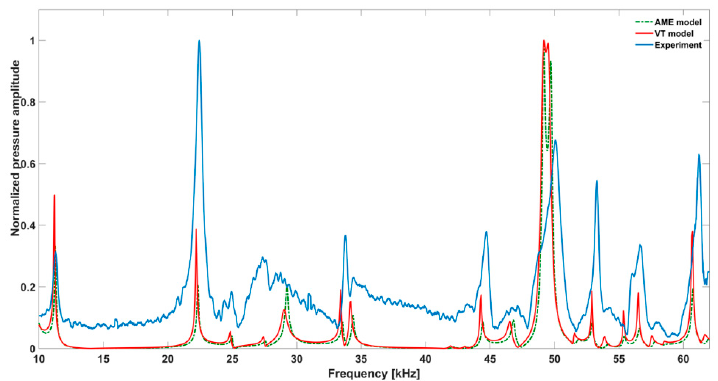
Figure 6. The frequency responses of the amplitude mode expansion (AME) model, the viscothermal (VT) model and the experimental measurement in the high frequency range.